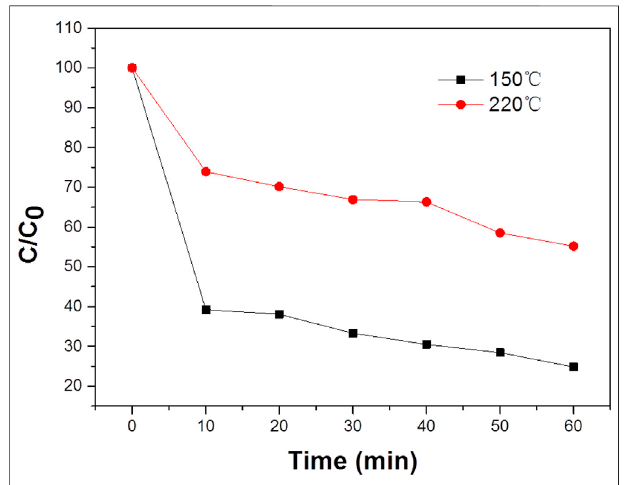
FIGURE 9 | The photodegradation pro fi le of MB in the presence of the WO 3 photocatalyst under NIR laser